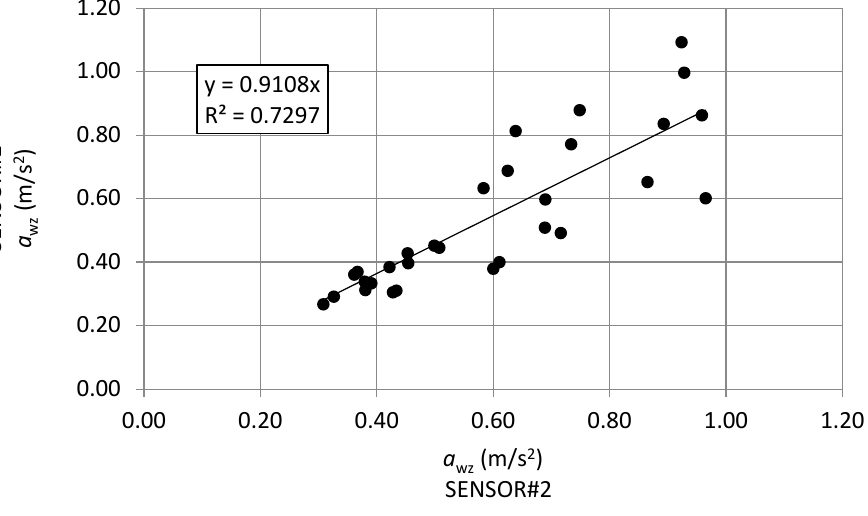
Figure 14. Linear regression SENSOR#1 -a wz vs. SENSOR#2 -a wz . The dispersion of data points around the regression line and a non-unit slope